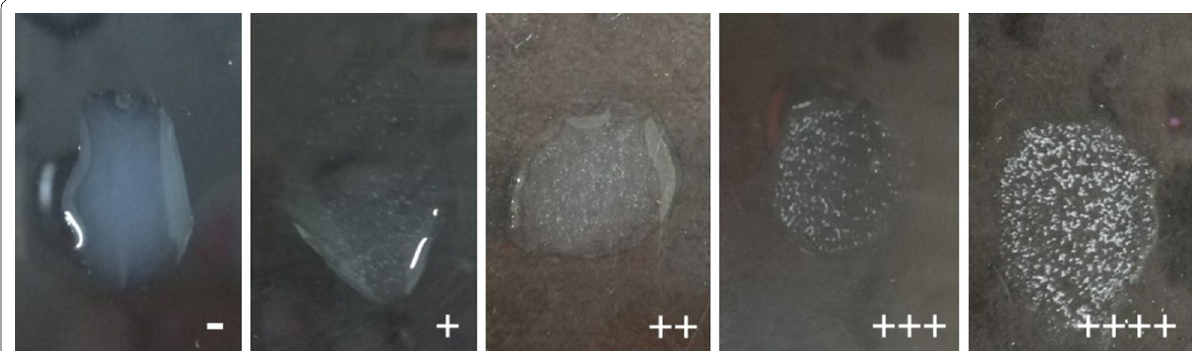
Fig. 5 Typical of agglutination assay: negative and positive (from reaction. “ ”, “ ”, “ ” and “ ” stands for strong positive, positive, mild positive, slightly positive reaction, respectively ++++ +++ ++ +